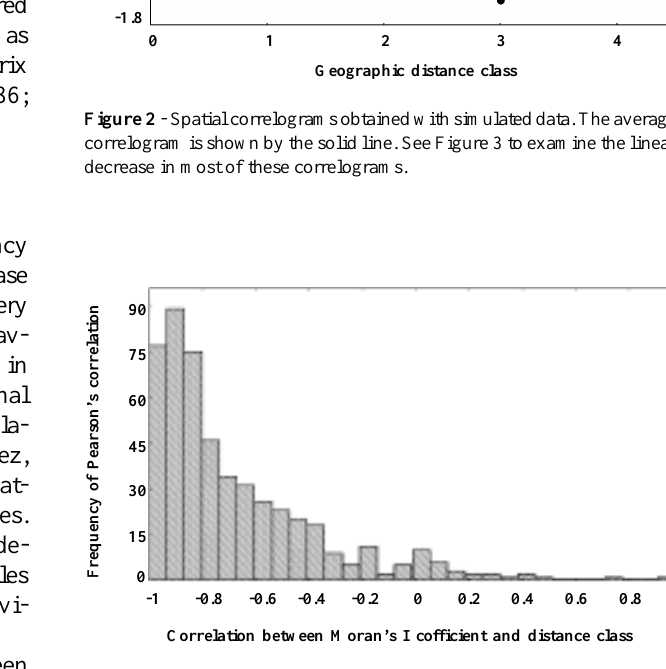
Figure 3 - Frequency distribution of correlations relative to Pearson’s correlation between Moran’s I coefficient and distance class. Note the high degree of linearity of the correlograms shown in Figure 2.